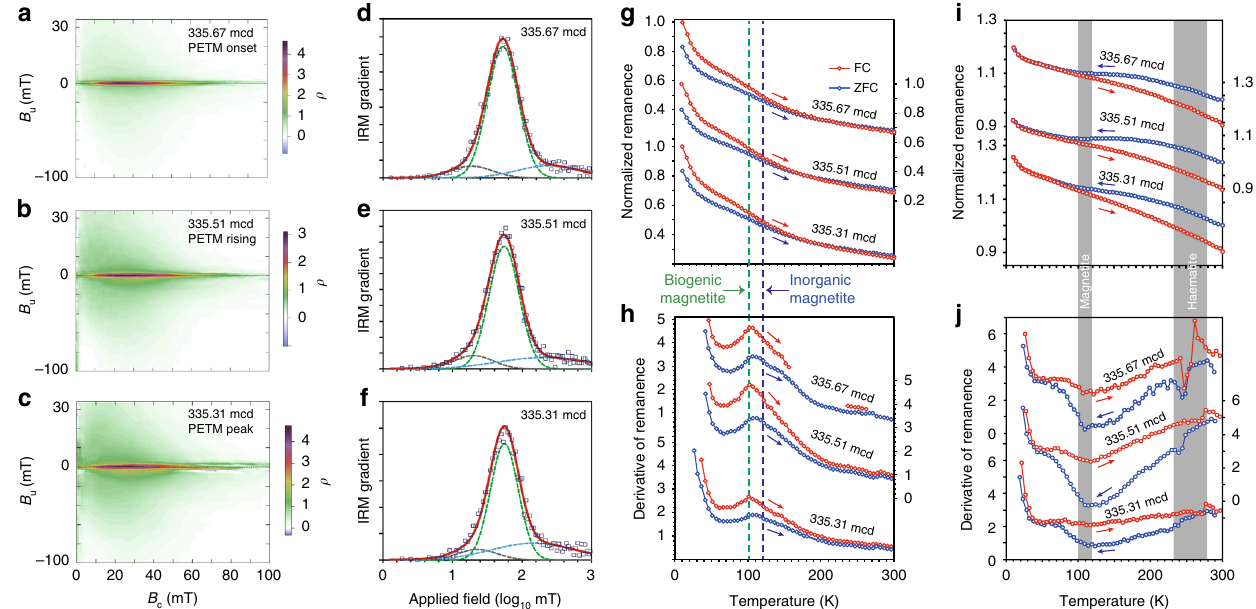
Fig. 2 Magnetic data for three typical PETM samples from ODP Hole 1263C. The three samples are section 14H-2A, 146 – 147 cm interval, at: 335.67 metres composite depth (mcd; PETM onset), section 14H-2A, 130 – 131 cm interval, at 335.51 mcd (rising PETM), and section 14H-2A, 110 – 111 cm interval, at 335.31 mcd (PETM peak). a – c FORC diagrams, d – f IRM coercivity components, g low-temperature SIRM warming and h corresponding derivative curves, and i LTC of a room temperature SIRM and j corresponding derivative curves. In d – f , squares indicate measured data, thick red lines are fi tted total coercivity spectra, and dashed lines represent fi tted components: green, biogenic magnetite; grey, detrital soft magnetic mineral assemblage; and blue, detrital hard magnetic mineral assemblage. In g , h , SIRM warming curves are normalized to the magnetization at 10 K in FC curves. Vertical dashed lines mark temperatures of 100 and 120 K (i.e., the Verwey transition temperatures for biogenic and detrital magnetite, respectively 46 . In i , j , LTC curves are normalized to the initial SIRM at room temperature. Grey bars indicate temperature intervals for phase transitions in magnetite and